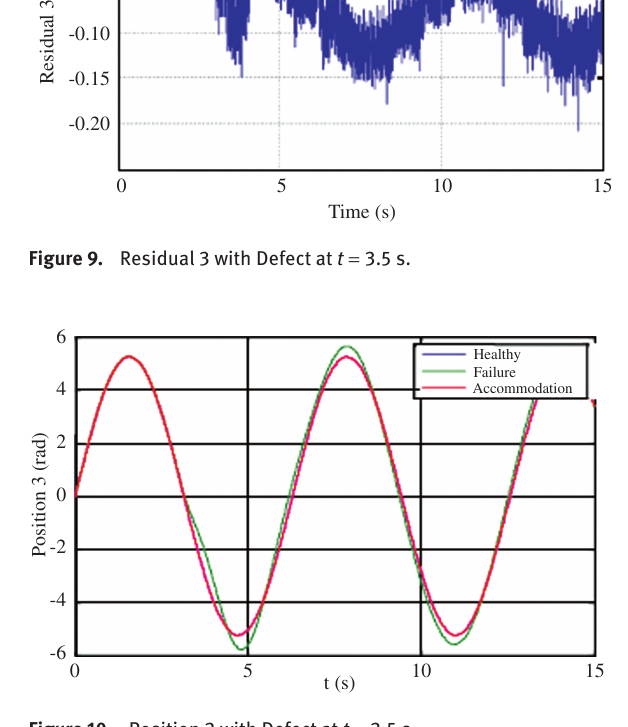
Figure 10. Position 3 with Defect at t = 3.5 s.